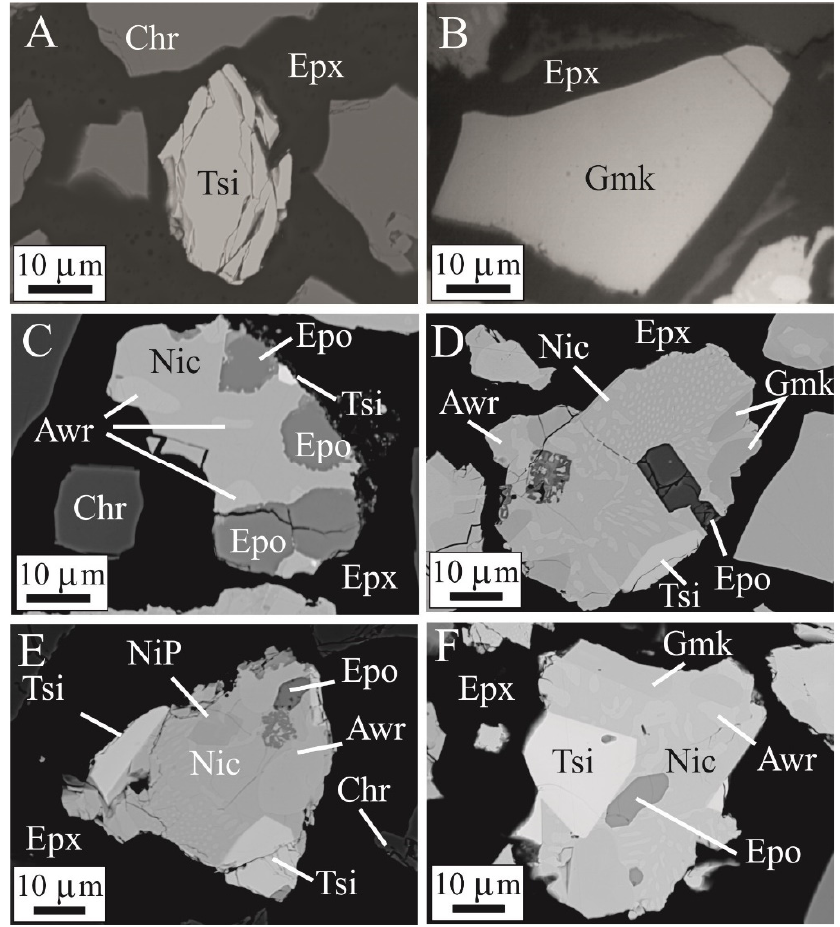
Figure 2. BSE images showing the new minerals found in the Agios Stefanos mine. Single-phase grains of tsikourasite ( A ) and grammatikopoulosite ( B ) and composite grains containing tsikourasite, grammatikopoulosite and eliopoulosite ( C – F ). Symbols: Tsi = tsikourasite, Gmk = grammatikopoulosite, Epo = eliopoulosite, Awr = awaruite, Nic = nickelphosphide, Chr = chromite, Epx = epoxy. Images modified after Zaccarini et al. [7]; Bindi et al. [8,9].